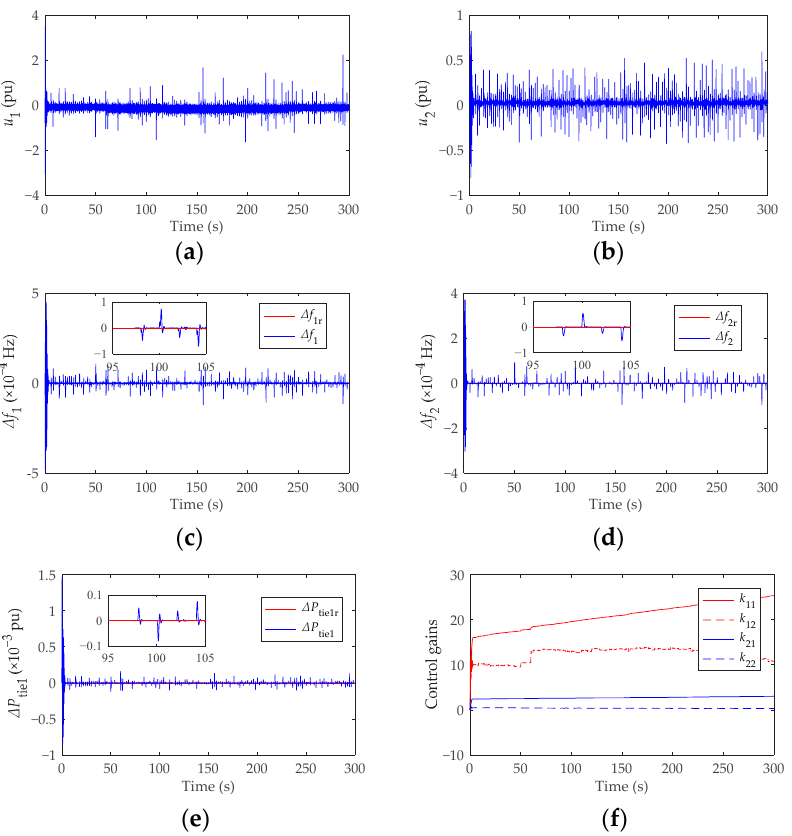
Figure 12. Results of two-area thermal power system ( a ) Control input u 1 . ( b ) Control input u 2 . ( c ) Frequency deviation ∆ f 1 . ( d ) Frequency deviation ∆ f 2 . ( e ) Tie-line power flow deviation ∆ P tie 1 . ( f ) Control gains k 11 , k 12 , k 21 , and k 22 .